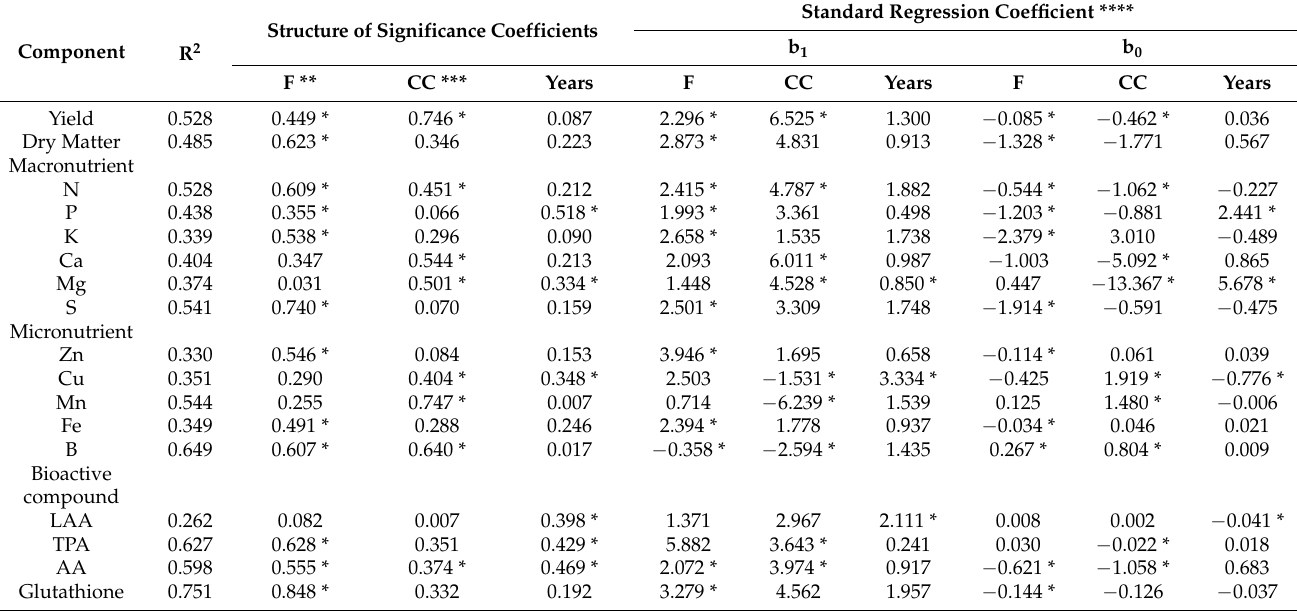
Table 6. Summary of regression